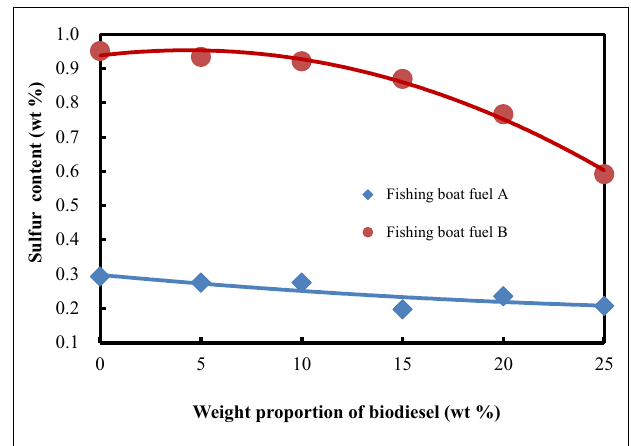
FIGURE 4 |Variation in sulfur content according to the weight proportion of biodiesel-blended in fishing boat fuelsA and B .